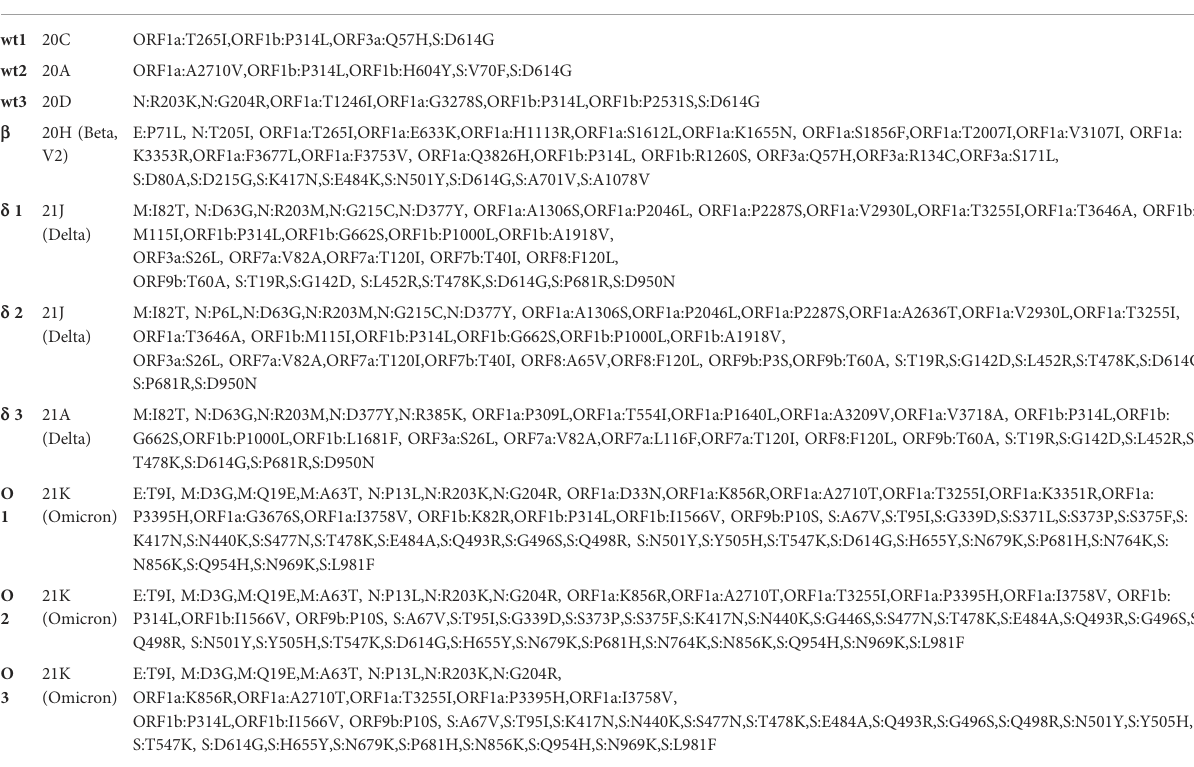
TABLE 2 Whole genome sequencing of SARS-CoV-2 viral isolates. Clade Amino acid